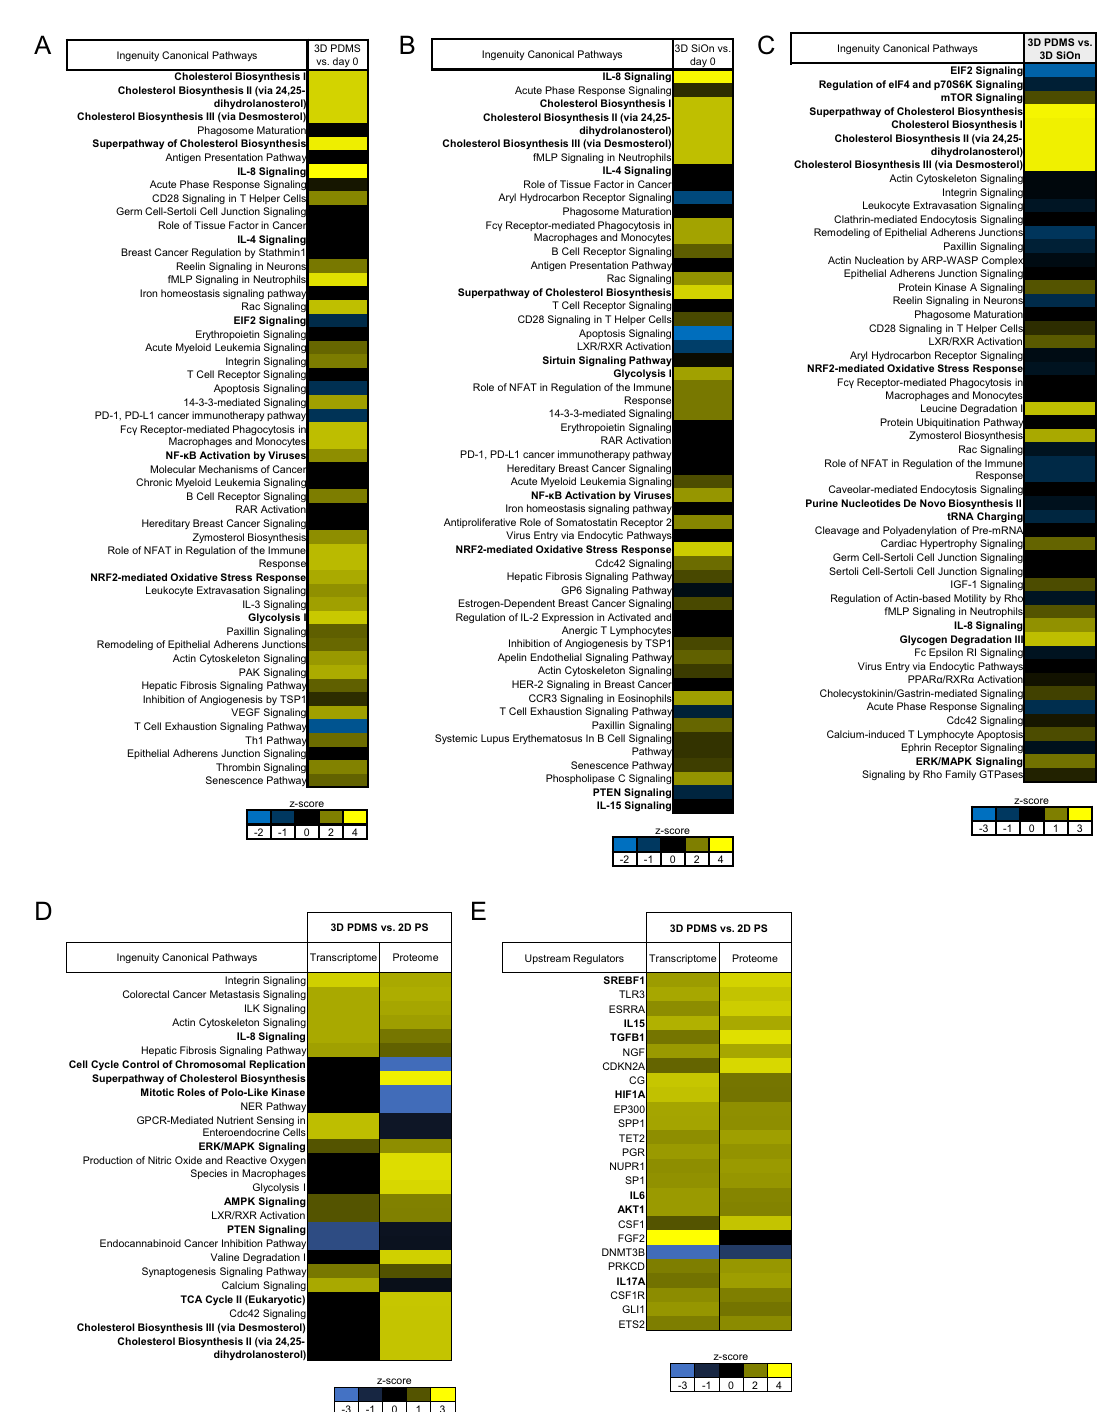
Figure 2. Human HSCs were cultivated for 14 days in vitro on 2D PS, 3D PDMS and 3D SiOn to expand high numbers of undifferentiated HSCs ex vivo. The proteome of the initial HSC population at day 0 and after 14 days in vitro on 2D PS, 3D PDMS and 3D SiOn scaffolds was analyzed by untargeted mass spectrometry (with 4 replicates per group) and the data sets were post-analyzed using IPA. Activation of cellular pathways (top 50) after 14 days in vitro on 3D PDMS ( A ) and 3D SiOn ( B ) scaffolds compared to day 0 (analysis cutoff: q < 0.05, log2-fold change > 0.5), and ( C ) activation of cellular pathways (top 50) after 14 days in vitro in comparison of 3D PDMS vs. 3D SiOn scaffolds (analysis cutoff: q < 0.05) is indicated by corresponding z-scores (blue inactivation/ yellow activation) and ranked by the − log(p-value) of individual pathways (most significant at the top). ( D , E ) Transcriptome and proteome data sets were compared using IPA (analysis cutoff: q < 0.05). ( D ) Activation of similar cellular pathways (top 25) and ( E ) activation of similar regulatory molecules (upstream regulators; top 25) after 14 days in vitro in comparison of 3D PDMS vs. 2D PS scaffolds is indicated by corresponding z-scores and ranked by the − log(p-value) of individual molecules. Important pathways/molecules are highlighted with bold